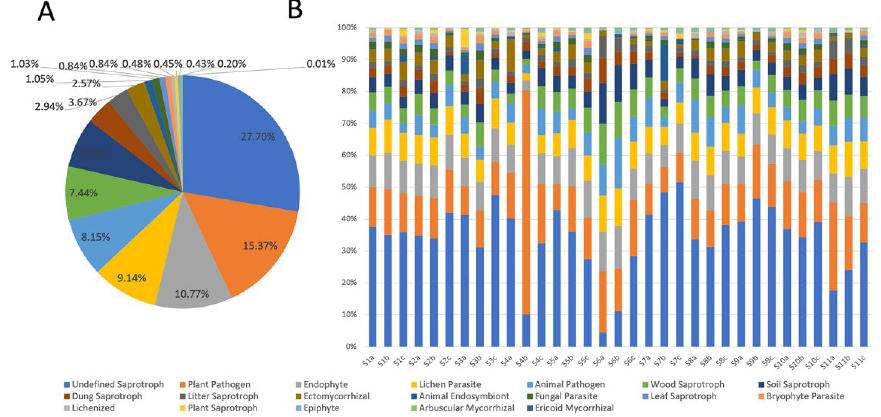
Figure 3. The ( A ) composition and ( B ) distribution of fungal trophic types in coastal sediments at 11 sites (S1–S11) in Guangdong province. Three replicates (e.g., S1a, S1b, S1c) were collected from each site.